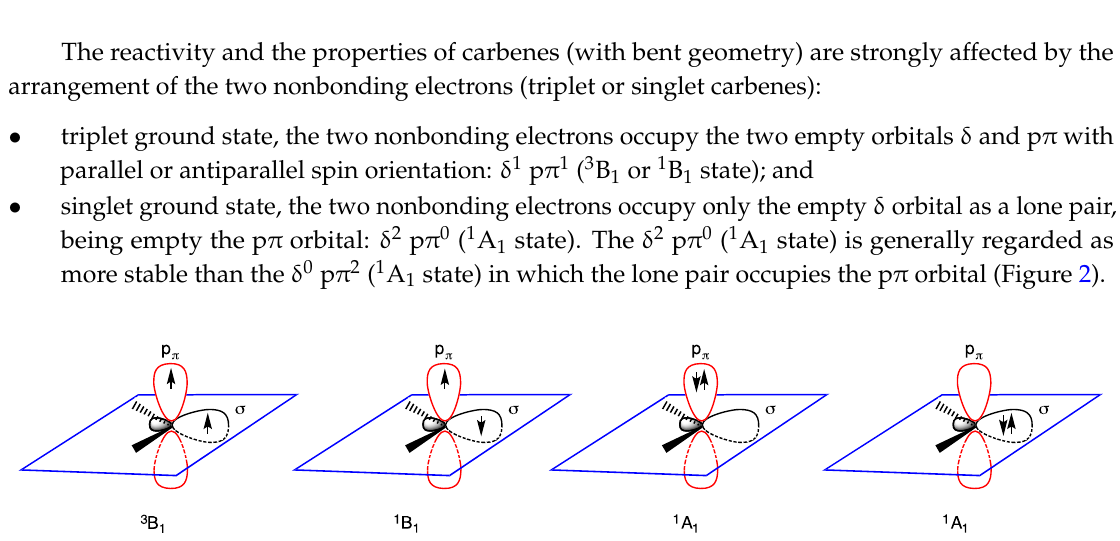
Figure 2. Triplet and singlet carbenes: electronic configurations. Arrows: electrons.